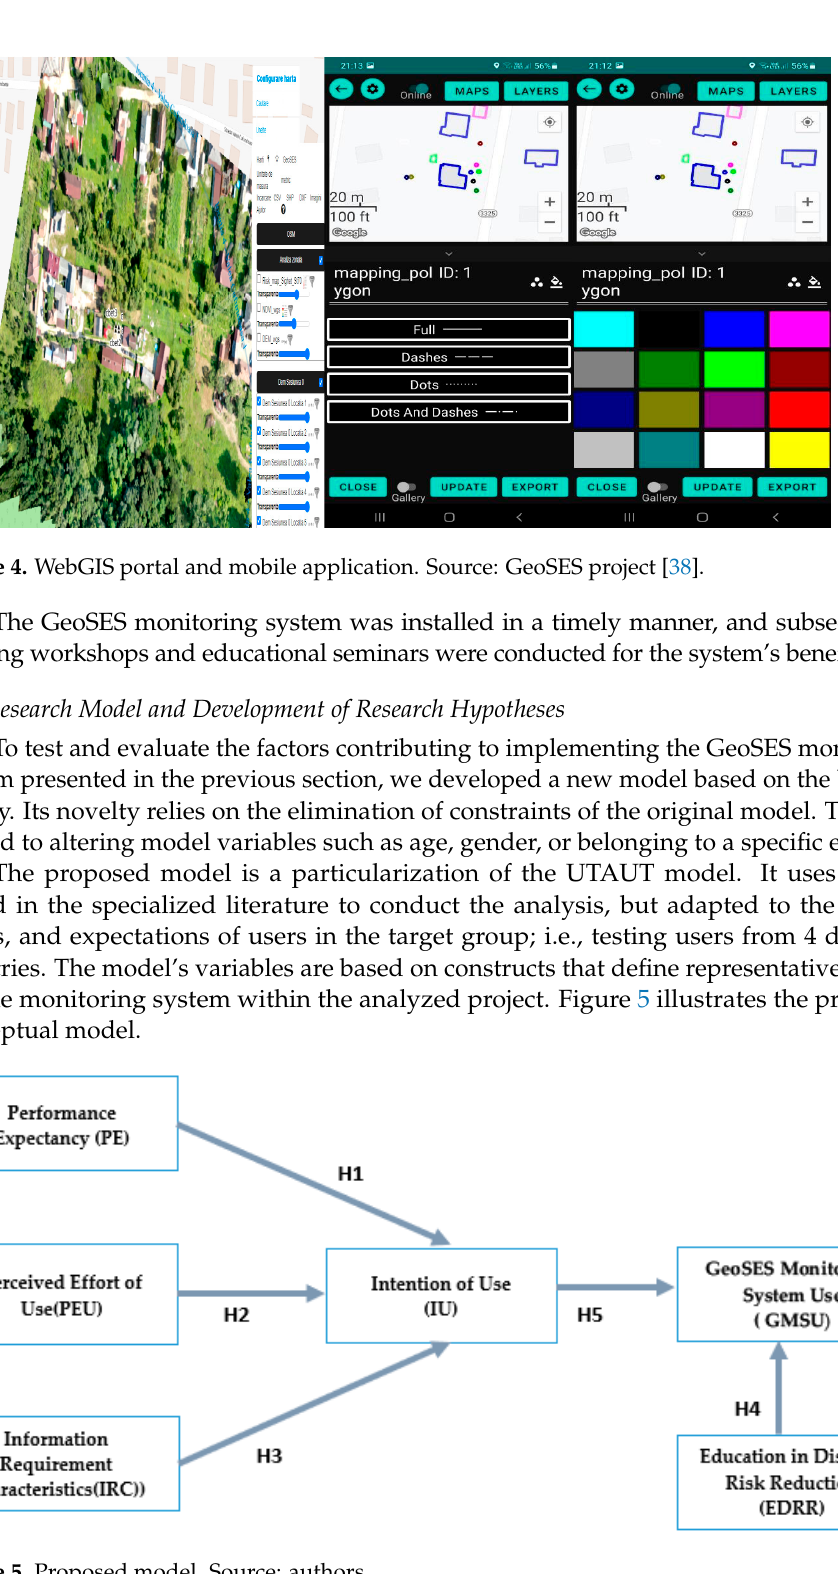
(municipal and local authorities/self-governments).